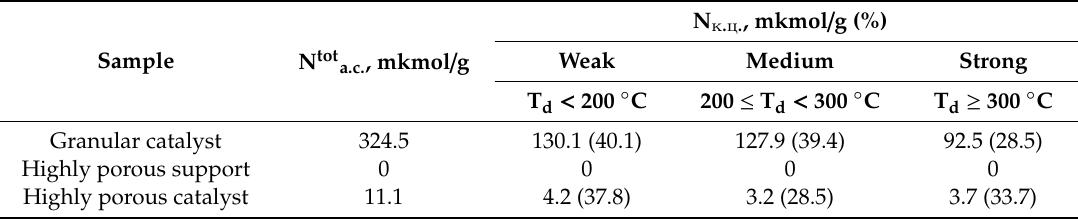
Figure 5. NH 3 –TPD curves: blue: granular catalyst; red: highly porous catalyst. Table 2. Concentration of acid centers of catalyst samples according to NH 3 -TPD.